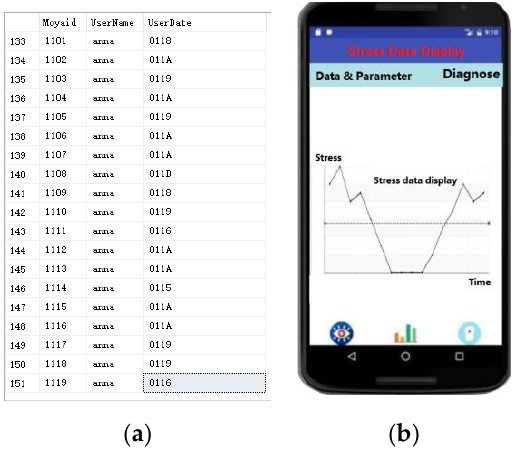
Figure 9. ( a ) Data stored in a table on the server; ( b ) data visualized with various curves in a mobile application.